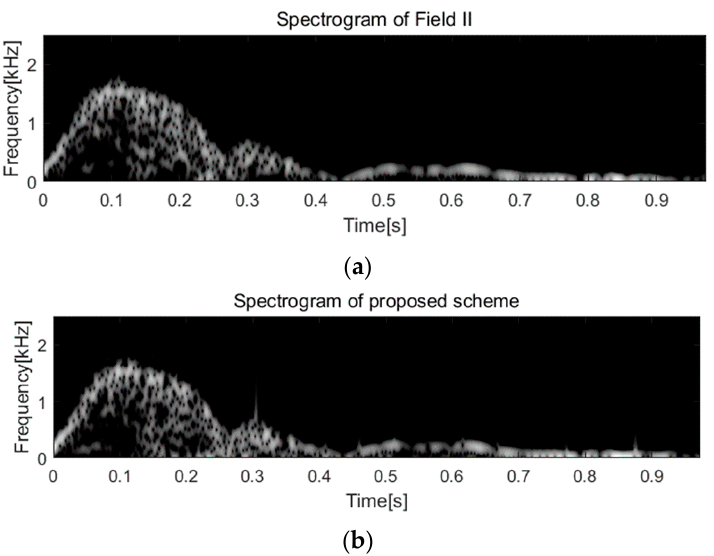
Figure 12. Behavioral simulation results of spectrograms from ( a ) Field II program and ( b ) proposed scheme.